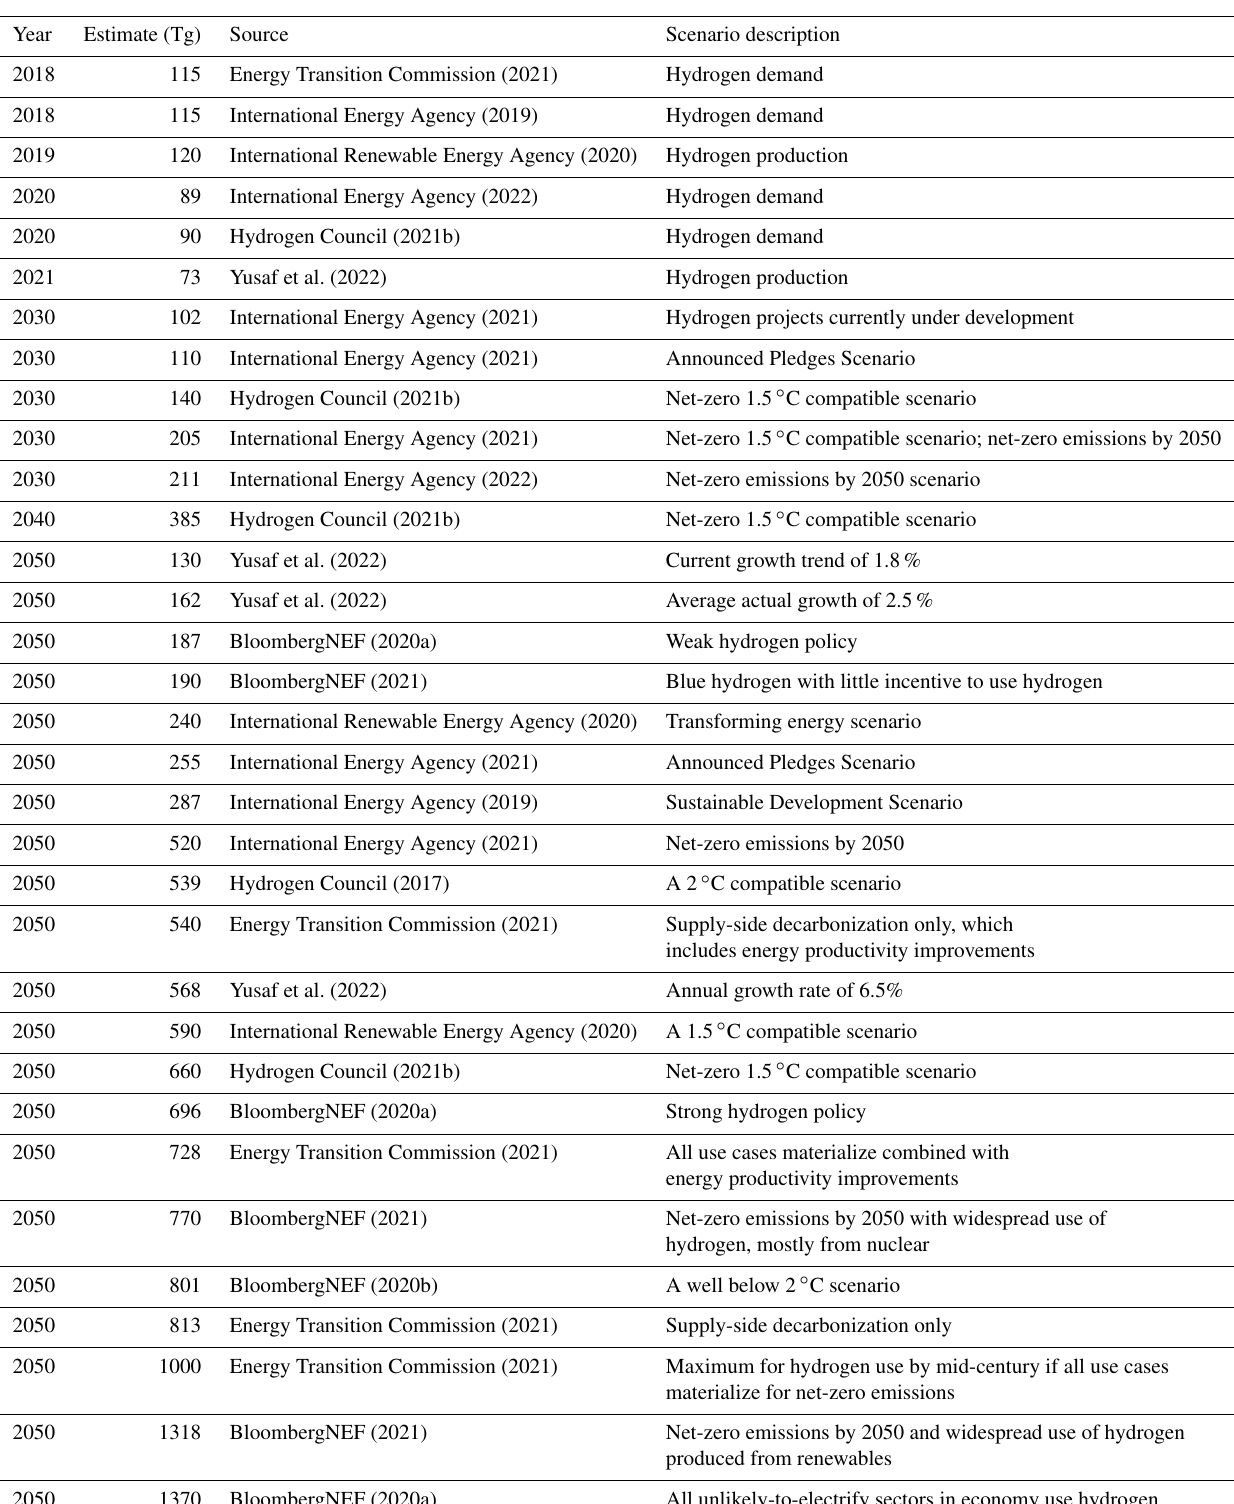
Table 3. Published estimates of hydrogen demand for various